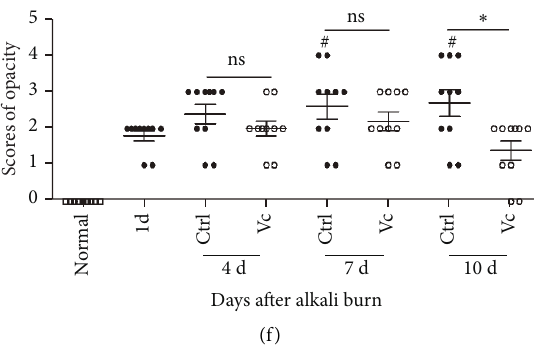
Figure 2: Clinical analysis of the alkali-burned corneas treated with vitamin C (Vc). (a) The corneas of the alkali-burned mice were stained with sodium fluorescein. (b) The results of the epithelial damage scores expressed as the mean ± SEM. (c) Representative images of neovascularization in the two groups. (d) The results of corneal neovascularization scores expressed as the mean ± SEM. (e) Representative images of corneal opacity in different groups. (f) The results of corneal opacity scores, expressed as the mean ± SEM. Abbreviations: Ctrl, control group (sterile water group); Vc, Vitamin C group; ns, no significant difference between the indicated groups. ∗ Means the comparison of Vc group and control group. # Means the comparison on day 1. ∗ p < 0 . 05, ∗∗ p < 0 . 01, and ## p < 0 . 01. Scale bar � 50 μ